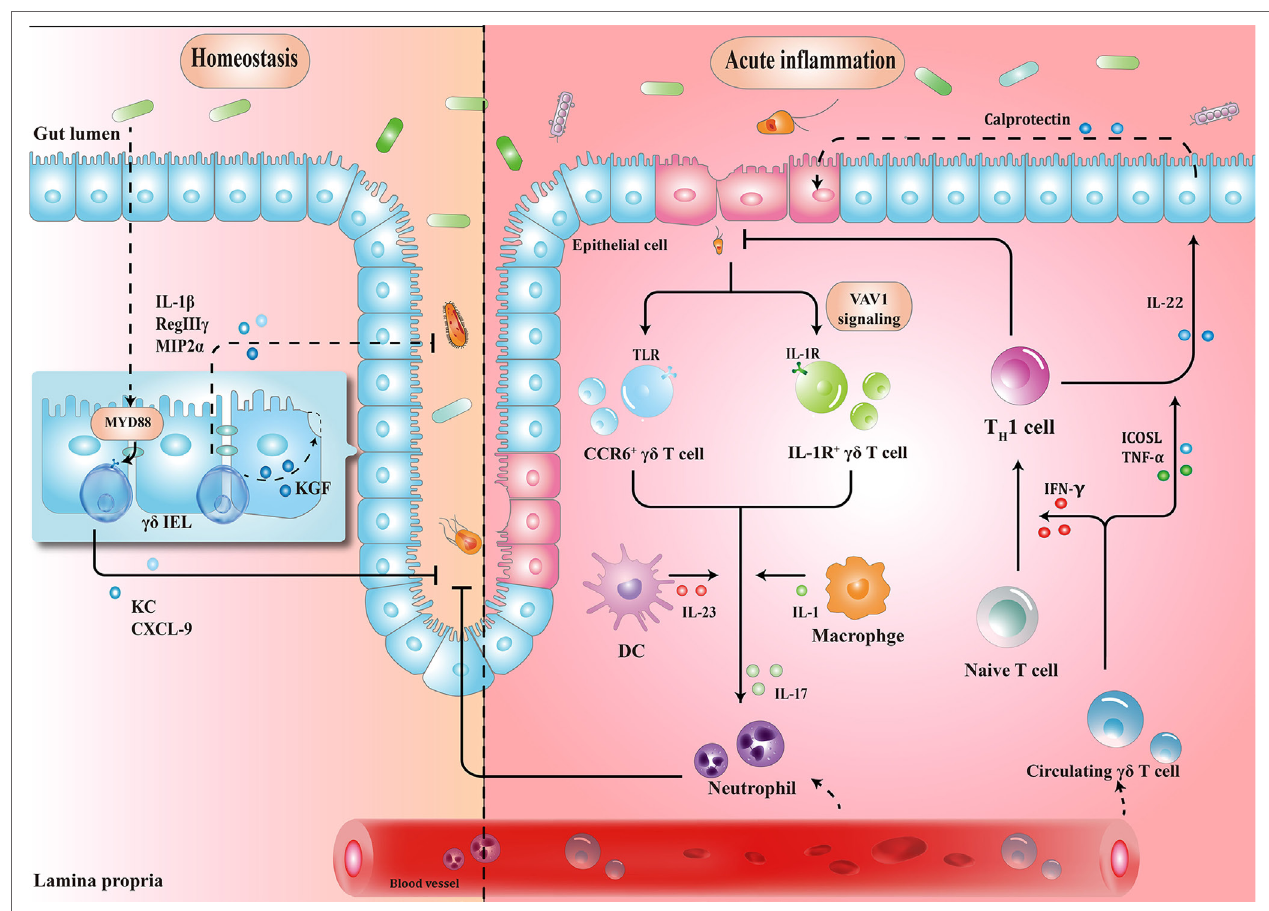
FigURe 1 | Schematic overview of the protective roles of γδ T cells in homeostasis maintenance and immune surveillance. (1) Physiologically, the crosstalk between microbiota, epithelial cells (ECs), and γδ T cells enhances barrier stabilization. (2) During acute inflammation, neutrophils are stimulated by IL­17 from γδ T cells, and recruited to eliminate pathogens. Meanwhile, microbe­activated circulating γδ T cells promote cytotoxic responses with Th1­committed αβ T cells and potentiate the release of calprotectin in an inducible T­cell co­stimulator ligand (ICOSL)/tumor necrosis factor α (TNF­ α )­dependent manner. IEL, intraepithelial lymphocyte; MYD88, myeloid differentiation primary response 88; KC, keratinocyte­derived chemokine; CXCL, chemokine (C­X­C motif) ligand; MIP2 α , macrophage inflammatory protein 2 α ; CCR, C­C motif chemokine receptor; TLR, toll­like receptor; IFN­ γ , interferon γ ; IL­17,